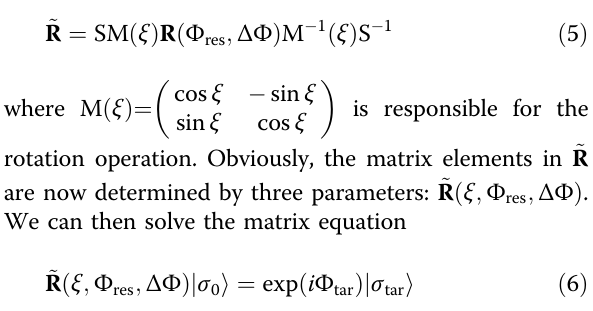
Figure 3c – d depict how the Φ res and ΔΦ of our meta- atoms vary against L u and L v , calculated at a wavelength of